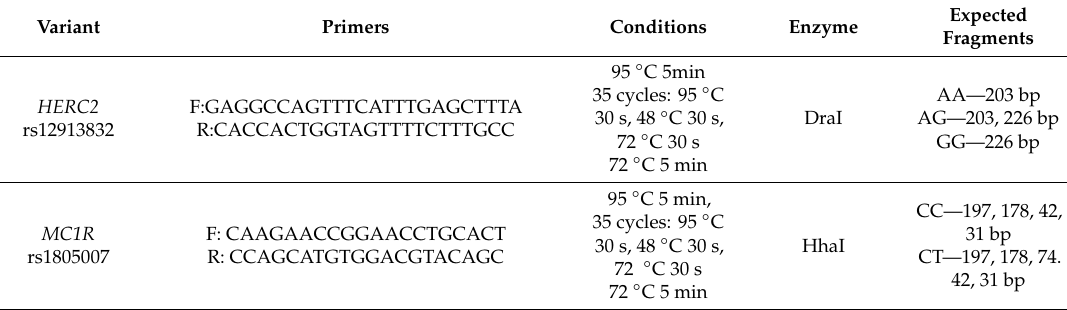
Table 1. PCR conditions for HERC2 rs12913832 and MC1R rs1805007